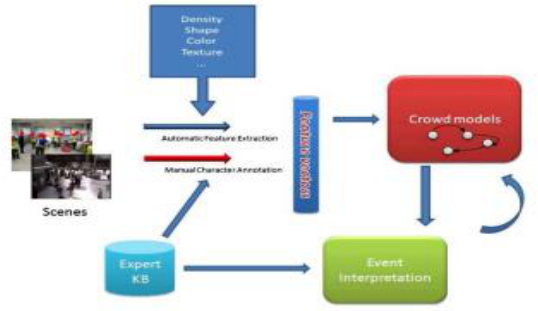
Figure 1 : Shows the general framework for crowd behavior tracking